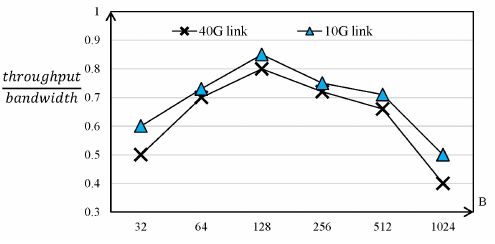
Figure 12. The standardized throughput of different sizes of cells.